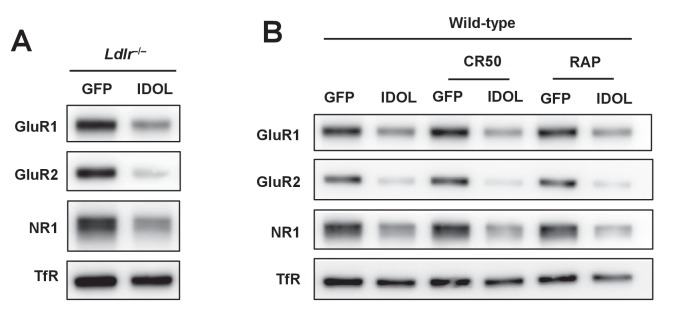
Excess IDOL activity inhibits spinogenesis by limiting ApoER2 protein.(A) Immunoblot analysis of total protein from Ldlr-/- hippocampal neurons. Neurons were transduced with either AAV-hSyn-GFP or AAV-hSyn-IDOL-GFP at DIV 5 and harvested at DIV18. (B) Immunoblot analysis of total protein from WT hippocampal neurons. Neurons were transduced with either AAV-hSyn-GFP or AAV-hSyn-IDOL-GFP at DIV 5, cultured in medium supplemented with CR50 (2 µg/ml) or RAP (2.5 µg/ml), and harvested at DIV18.